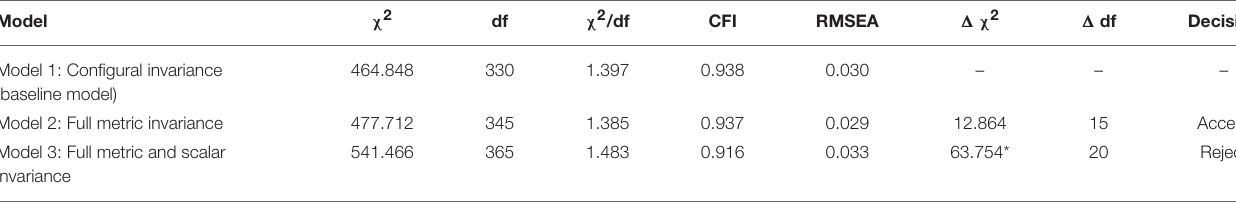
TABLE 4 | Goodness-of-fit statistics for tests of invariance across telephone counseling and face-to-face: a summary.